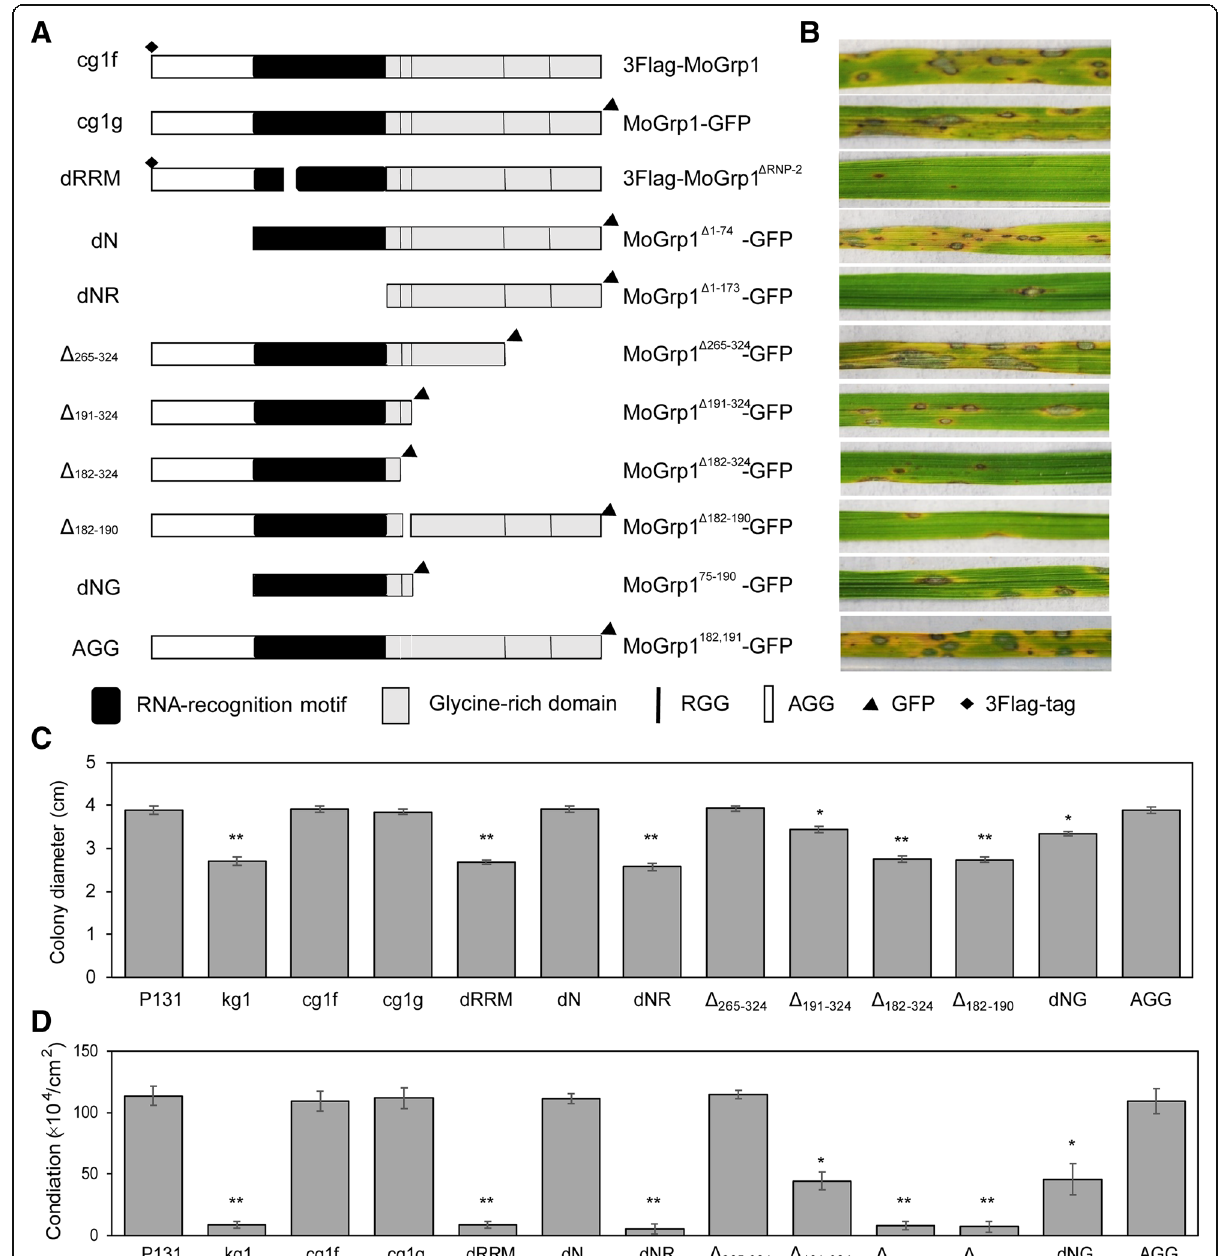
Fig. 7 Both the RRM and the first two RGG motifs are essential for the full function of MoGrp1. a Structure diagram of N-terminal 3 × Flag tagged MoGrp1 (cg1f), C-terminal GFP tagged MoGrp1 (cg1g) and their mutated alleles, including RNP-2 deletion (dRRM, MoGrp1 Δ 119 – 125 ), N-terminal deletion (dN, MoGrp1 Δ 1 – 74 ), glycine-rich domain complement transformant (dNR, MoGrp1 Δ 1 – 173 ), deletion from the 3rd RGG motif to the end ( Δ 265 – 324 , MoGrp1 Δ 265 – 324 ), deletion from the 2nd RGG motif to the end ( Δ 191 – 324 , MoGrp1 Δ 191 – 324 ), deletion from the 1st RGG motif to the end ( Δ 182 – 324 , MoGrp1 Δ 182 – 324 ), deletion from 182 to 190 aa ( Δ 182 – 190 , MoGrp1 Δ 182 – 190 ), transformant containing RRM and 1st RGG (dNG, MoGrp1 75 – 190 ), and AGG mutant (AGG, MoGrp1 R182A, R191A ); b Pathogenicity test of diverse domain-complemented strains in rice seedlings. Typical disease lesions were photographed at 5 – 7 dpi; c Colony diameter of diverse domain-complemented strains on OTA plates at 28 °C for 5 days. The mean ± SD was calculated based on three independent experiments measuring three plates in each replicate. * P < 0.05; d Conidiation capacity of diverse domain-complemented strains on OTA plates. The mean ± SD was calculated based on three independent experiments with measuring three plates in each replicate. * P <